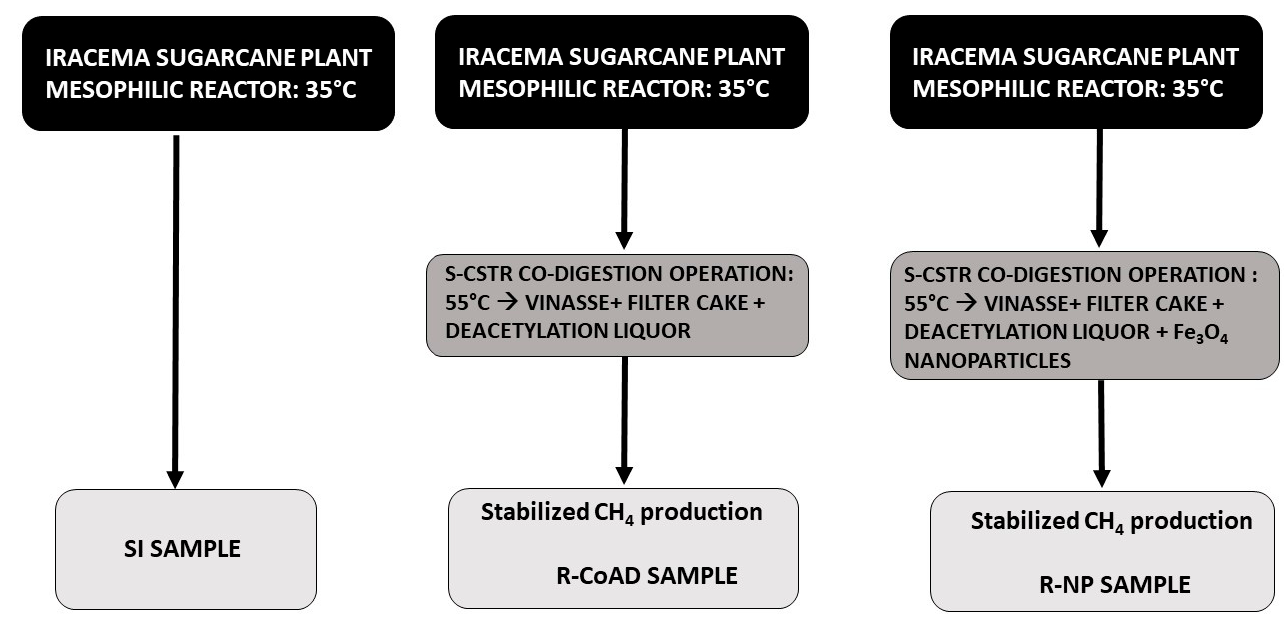
Figure 1. s-CSTR operation scheme and obtaining samples for proteomics analysis. Table 2. Summary of operating results of the two reactors used for sample removal for proteomics analysis.